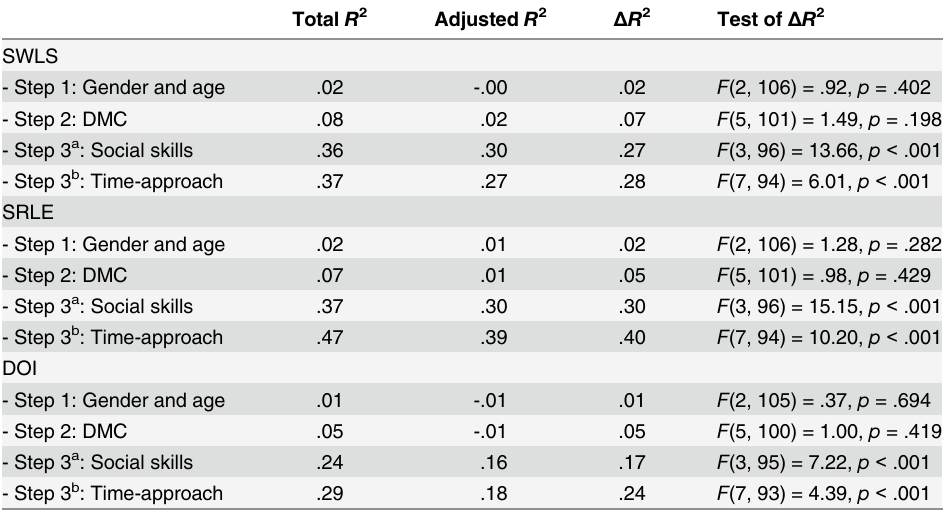
by use of the respective blocks of predictors: 1) gender and age , 2) DMC and, 3a) Social skills and 3b) Time-approach respectively. That is, in line with the analyses performed in Study 2, the predictive validity of Social skills and Time-approach were tested in two separate blocks 3 of the regression model. Predicting satisfaction with life: As Table 7 shows, Step 1 ( gender and age ) explained 2% of the variability in SWLS (n.s.). In Step 2, the DMC added 7% to the explained variance (n.s.). Although the contribution of the DMC block was not significant, the component Resistance to Framing (RTF) was found to be a significant predictor ( β = .227, p = .026). Next, when the block Social skills was added in Step 3, the explained variance increased by 27% ( p < .001). Here, the TEIQue-SF ( β = .577, p < .001) was the significant predictor. When instead measures of Time-approach were inserted into Step 3, this block accounted for an additional 28% of the variance ( p < .001). Here, the anxious ( β = -.423, p < .001) and the preference for economic time ( β = .228, p = .028) time styles were the significant predictors. Predicting recent life experiences: Using daily hassles (SRLE) as the outcome measure, mul- tiple regression analyses showed that neither the contribution of Step 1 ( gender and age ) nor Step 2 ( DMC ) was significant. In Step 3, when Social skills was added to the model, the explained variance increased by 30% ( p < .001). Here, the SMS subscale ability to modify self- presentation ( β = .267, p = .016) and TEIQue-SF ( β = -.659, p < .001) were the significant predictors. Moreover, using measures of Time-approach in Step 3 added a total of 40% of explained variance ( p < .001). In this block, the future-oriented ( β = .246, p = .014), submissive ( β = -.235, p = .015), and anxious ( β = .263, p = .006) time styles were found to be the significant predictors. Predicting objective decision outcome: When scores on the Decision Outcome Inventory (DOI) were used as the outcome measure, Step 1 ( gender and age ) explained 2% of the variabil- ity whereas Step 2 ( DMC ) added another 5%. However, neither Step 1 nor Step 2 made a signif- icant contribution. Next, when measures of Social skills were used in Step 3 of the model, the